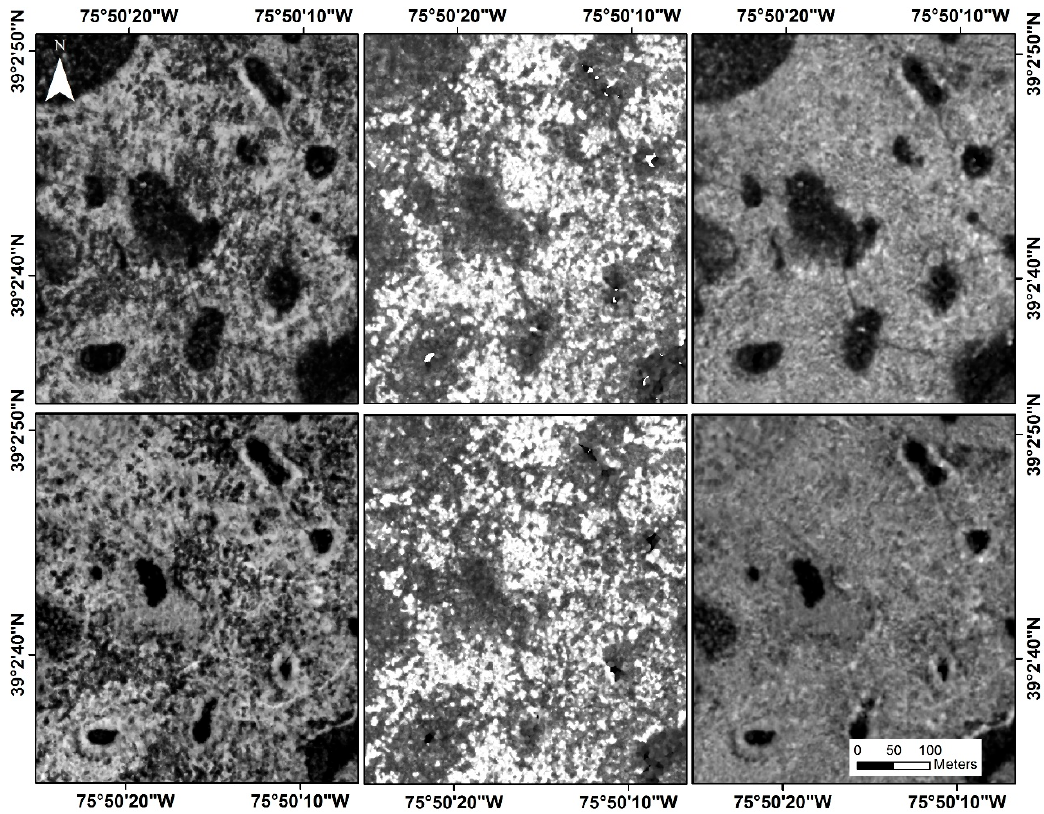
Figure 7. Bare earth ( left ), first ( middle ), and normalized bare earth return images ( right ) from 27 March, 2007 ( top ) and 24 March, 2009 ( bottom ) for the same area of mixed deciduous and evergreen forest. Note that inundated areas (dark signature) are easier to identify on the normalized bare earth images relative to the original bare earth images, and that while bare earth images change between years, first return images remain relatively constant.